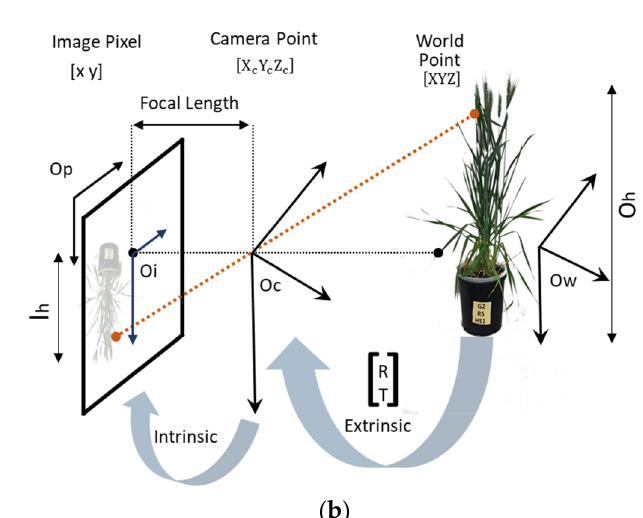
Figure 3. Process of capturing images and radial optical distortion. ( a ) An image without distortion (top) and image with radial barrel distortion (bottom) where r is the off-axis image distance, which increases with distortion. ( b ) Extrinsic parameters (Rotation (R) and Translation (T)) are used to convert the 3D world plane coordinates (O w ) to a 3D camera plane coordinates (O c ), which are converted to 2D image coordinates (O i ) with the help of intrinsic parameters; O p represents the pixel plane.